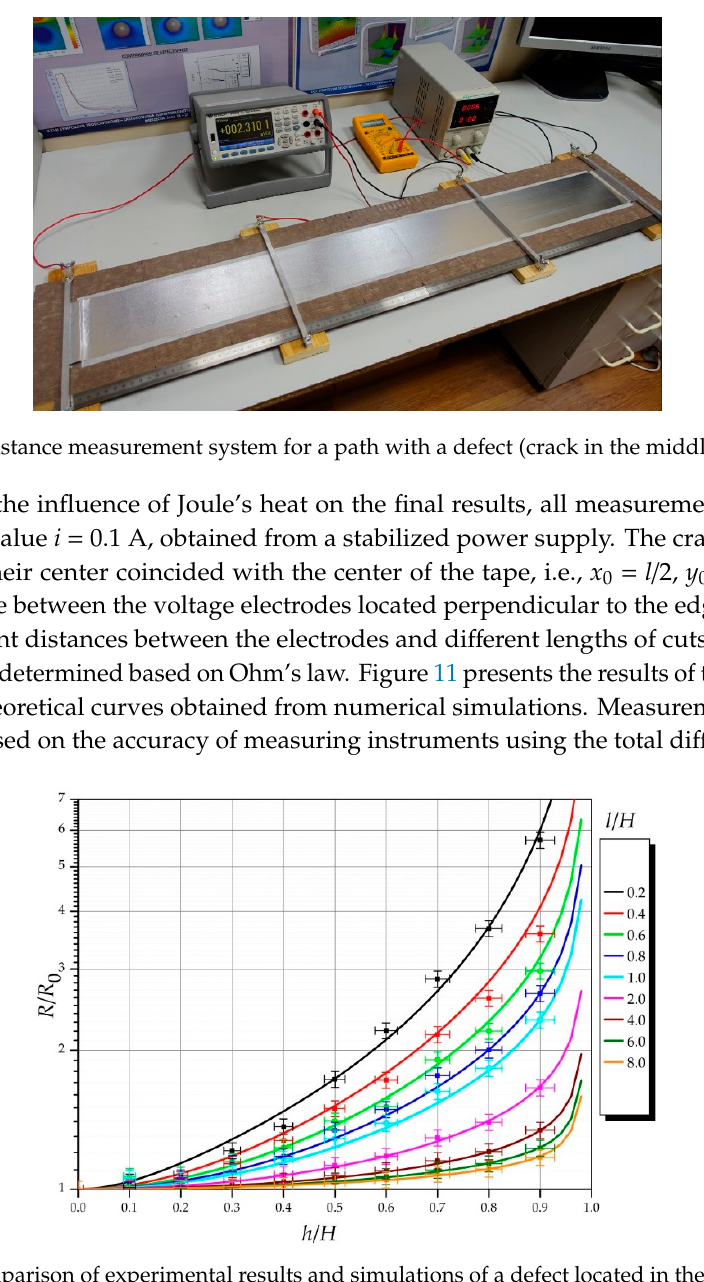
Figure 11. Comparison of experimental results and simulations of a defect located in the central part of the path.